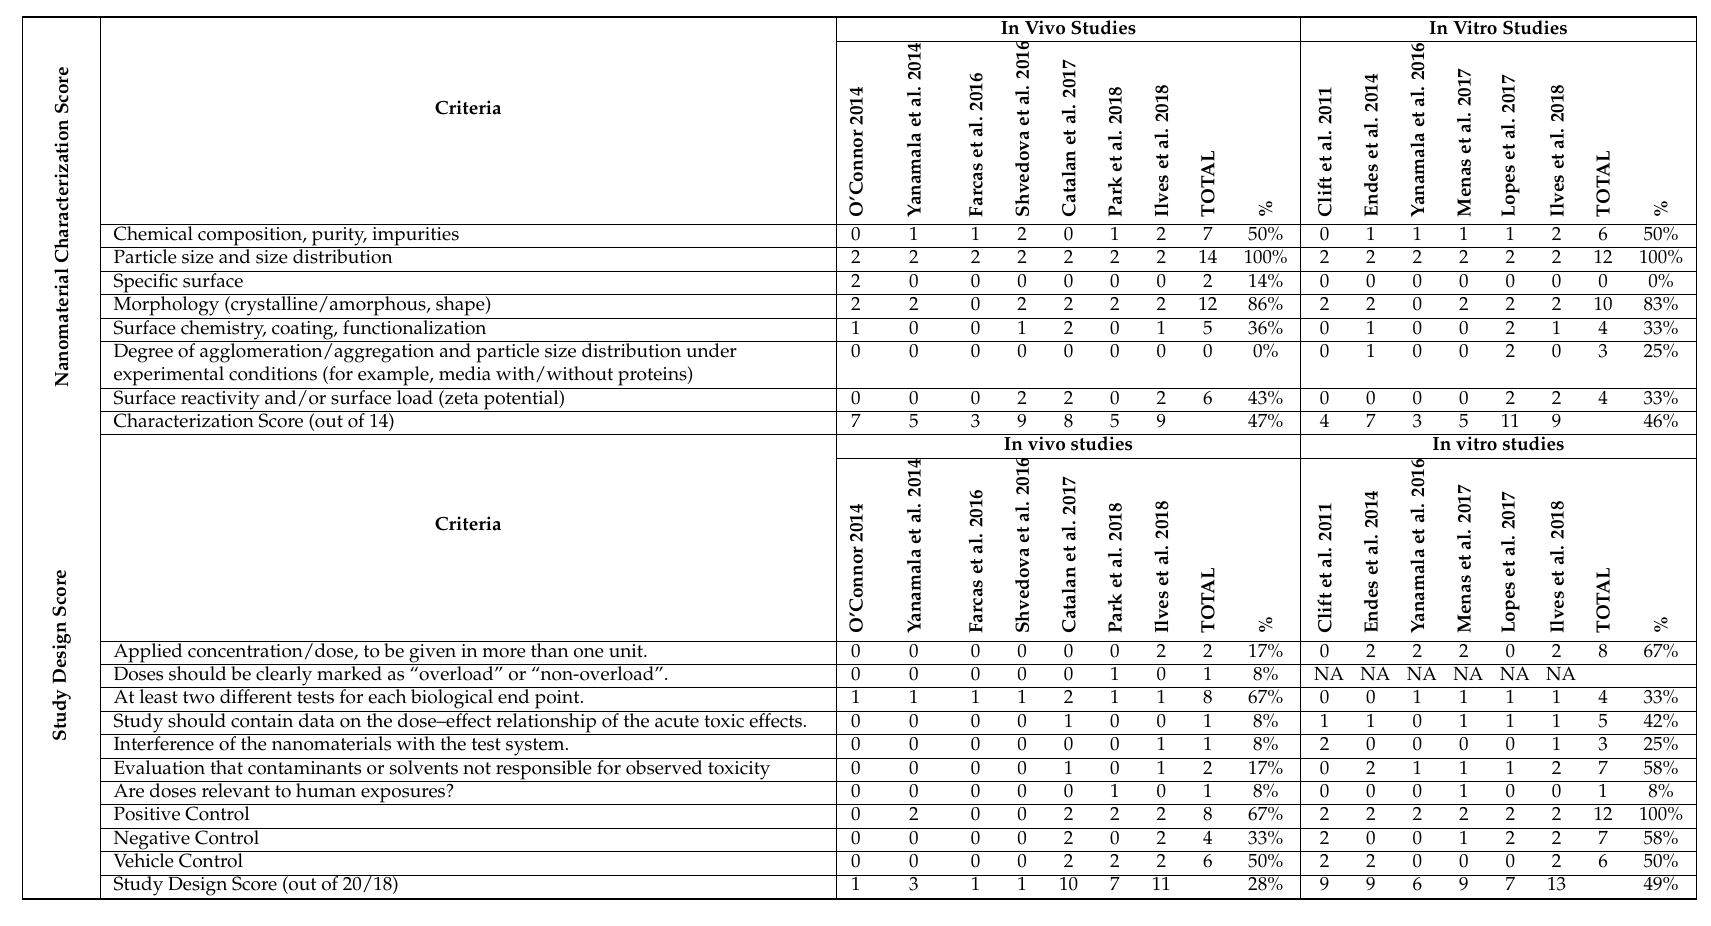
Table 2. Summary of Krug and Wick study